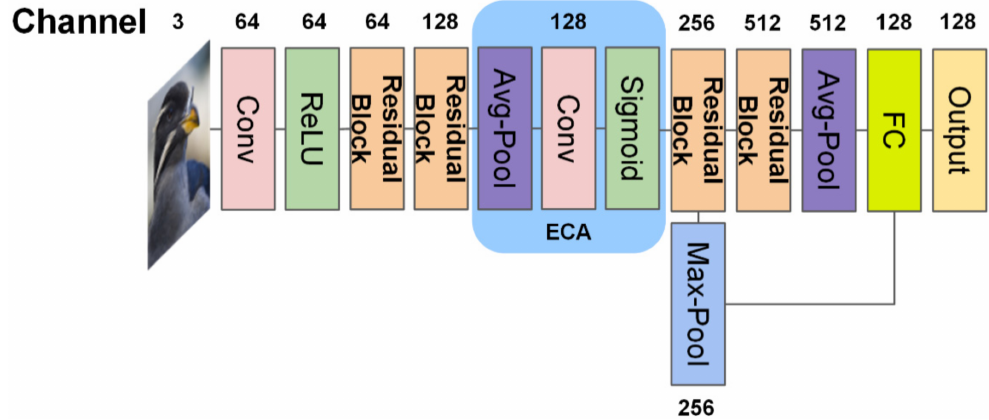
Figure 3. ECAResNet-12 network